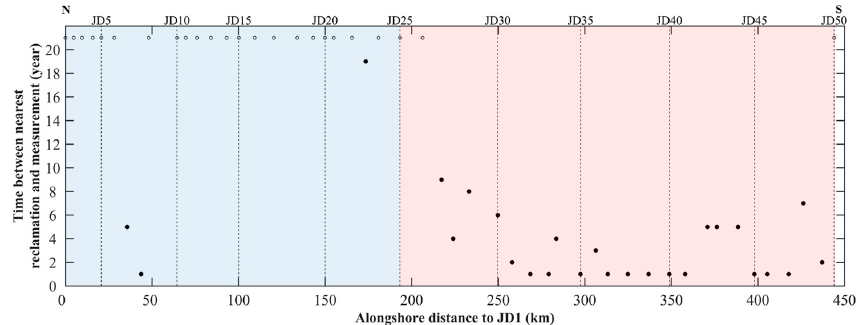
Figure 10. Time between measurement and nearest reclamation at each profile (circles means time larger than 20 years).